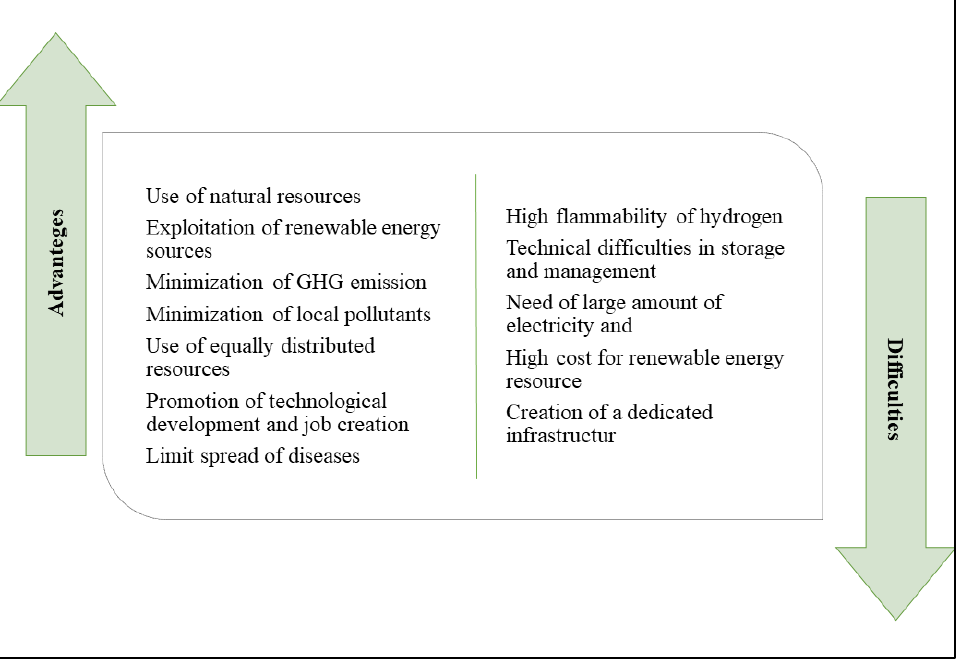
Figure 5. Advantages and difficulties of green hydrogen industry.